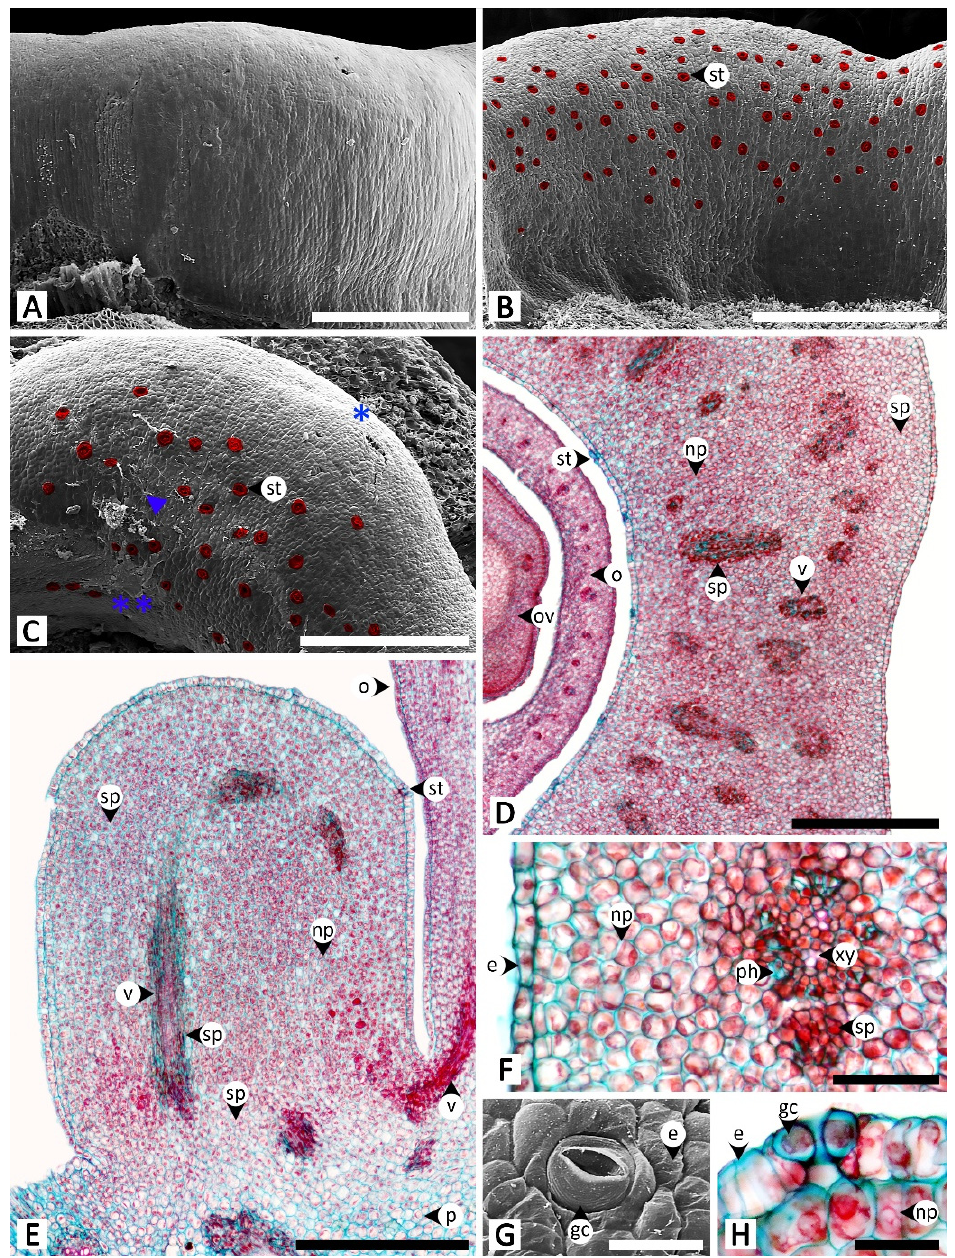
Figure 2. Micromorphology and anatomy of the nectary disc of Rivea ornata . ( A ) Abaxial surface without nectarostomata. ( B ) Adaxial surface showing the distribution of nectarostomata (highlighted in red). ( C ) Top view of the nectary disc showing nectarostomata (highlighted in red) located on the apical region and down along the adaxial side (double asterisk) but absent from the abaxial side (single asterisk), with trace amounts of exudate (arrowhead). ( D ) Transversal and ( E ) longitudinal views showing the epidermis, nectariferous parenchyma, subnectariferous parenchyma, and vascular tissues. ( F ) Close-up view of ( D ) from an area near the adaxial surface. ( G ) Surface image of nectarostoma. ( H ) Transversal section of nectarostoma. Note: ( A – C , G ) were taken with a scanning electron microscope, while ( D – F , H) were taken with a light microscope. Abbreviations: e, epidermal cell; gc, guard cell; np, nectariferous parenchyma; o, ovary; ov, ovule; p, parenchyma; ph, phloem; sp, subnectariferous parenchyma; st, stoma; v, vascular tissue; xy, xylem. Scale bars: ( A – C ) 500 μ m; ( D , E ) 1000 μ m; ( F ) 250 μ m; ( G , H ) 50 μ m.